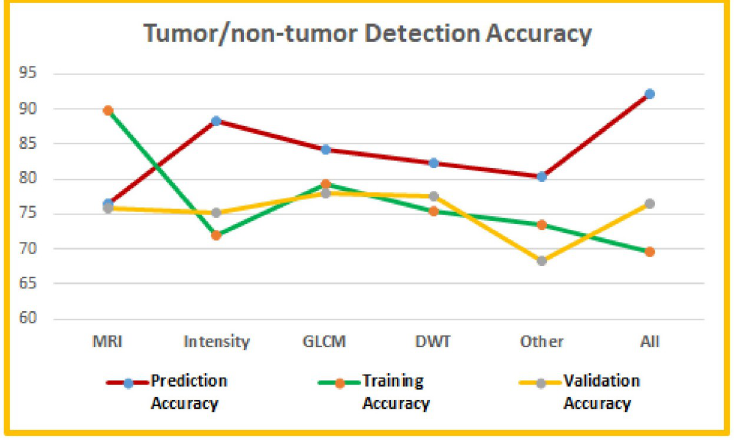
Fig 23. Performance comparison for tumor/non-tumor detection